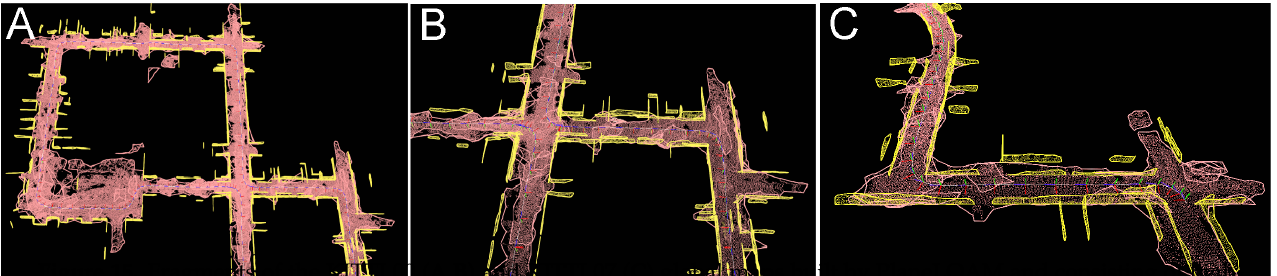
Figure 15. Fragments of the KITTI 00 ( A , B ) and KITTI 07 ( C ) global maps built by PlaneLOAM and consisting of high- level geometric features. Approximately vertical planar features are shown in yellow, while orange patches denote the ground